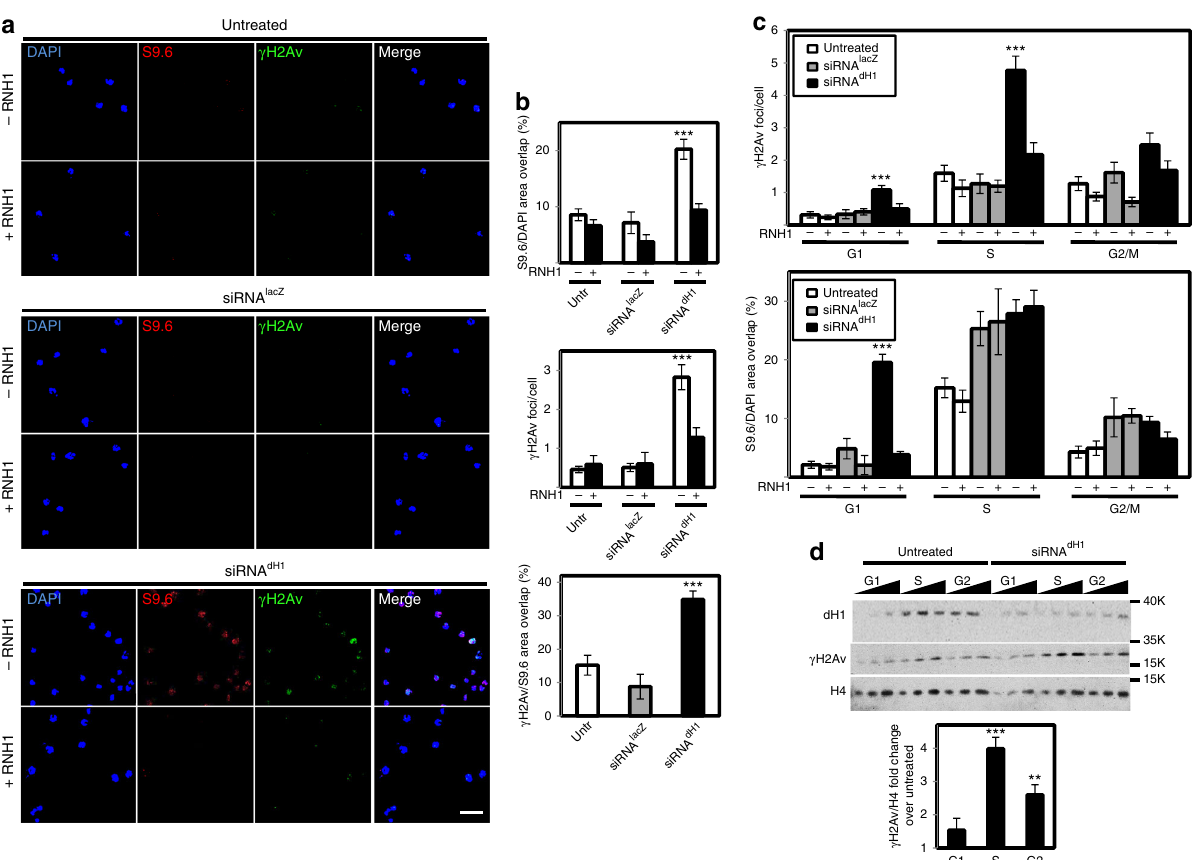
Fig. 4 DNA damage induced by dH1 depletion associates with R-loops accumulation. a Immunostainings with αγ H2Av ( green ) and S9.6 ( red ) antibodies of siRNA dH1 , siRNA lacZ and untreated cells overexpressing human RNH1 (+) or not ( − ). Scale bar corresponds to 10 μ m. b Quantitative analysis of the results shown in a . S9.6 ( top ) and γ H2Av ( center ) reactivities determined as the proportion of DAPI area stained with S9.6 antibodies and the number of γ H2Av foci per cell are presented ( n > 50 for each condition). On the bottom , the extent of γ H2Av/S9.6 colocalization is presented as the proportion of γ H2Av area overlapping with S9.6 reactivity ( n > 50 for each condition). Error bars are s.e.m. The p -values of siRNA dH1 respect to siRNA lacZ are indicated (no asterisk > 0.05, *** < 0.005; two-tailed Student ’ s t -test). c αγ H2Av ( top ) and S9.6 ( bottom ) reactivities of G1-, S- and G2/M-phase sorted siRNA dH1 , siRNA lacZ and untreated cells overexpressing RNH1 (+) or not ( − ) are presented as in b ( n > 50 for each condition). Error bars are s.e.m. The p -values of siRNA dH1 respect to siRNA lacZ are indicated (no asterisk > 0.05, *** < 0.005; two-tailed Student ’ s t -test). d WB analyses with α dH1, αγ H2Av and α H4 antibodies of siRNA dH1 and untreated cells sorted at G1-, S and G2/M-phase. The positions corresponding to molecular weight markers are indicated. Quantitative analysis is shown on the bottom ( N = 2). Error bars are s.e.m. The p -values respect to untreated are indicated (no asterisk > 0.05, ** < 0.01, *** < 0.005; two-tailed Student ’ s t